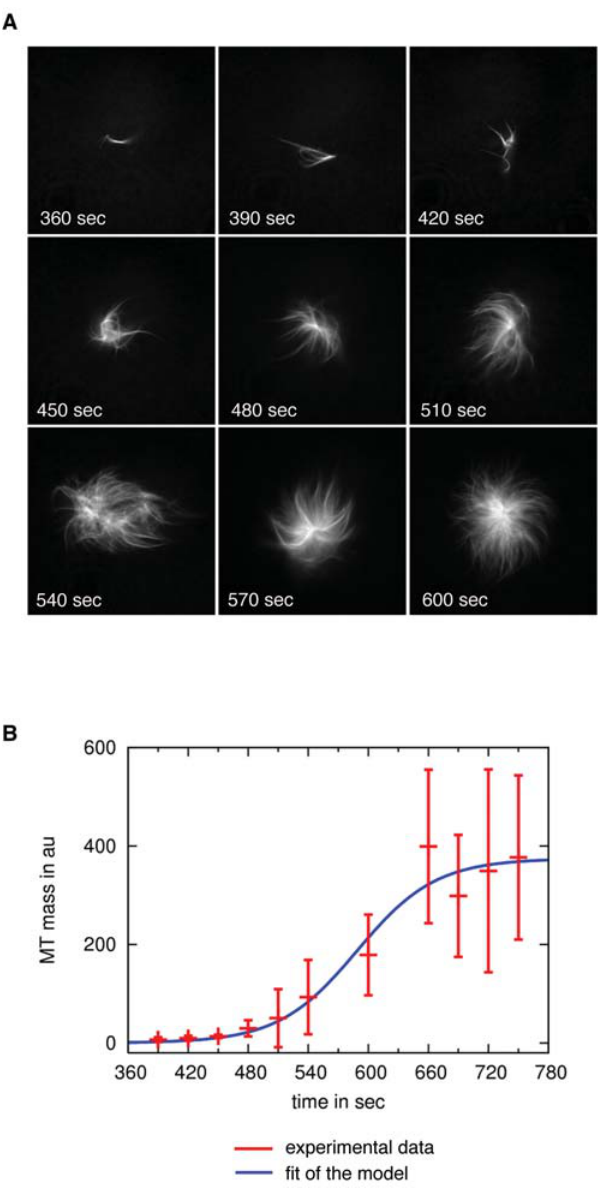
Figure 1. During RanQ69L-mediated aster formation, MTs appear to accumulate exponentially at an initial seed MT. A. Quantification of RanQ69L-mediated MT production in meiotic Xenopus egg extract. RanQ69L was added to Xenopus extract to initiate the formation